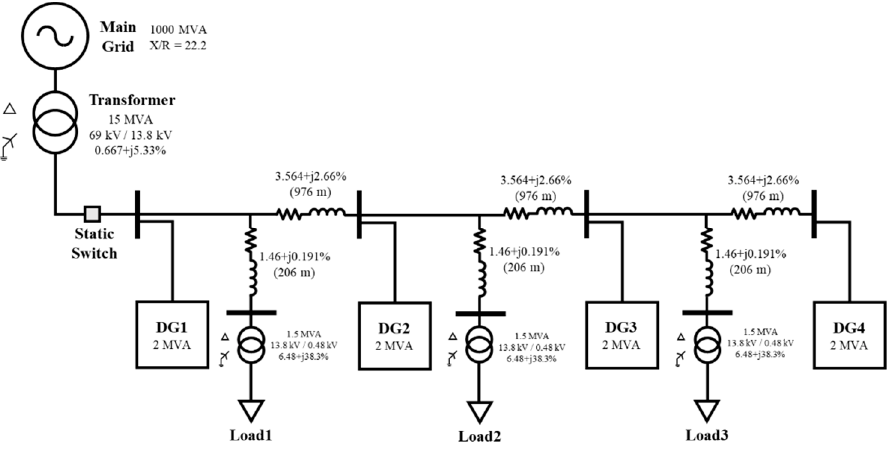
Figure 4. One-line diagram of the studied microgrid.